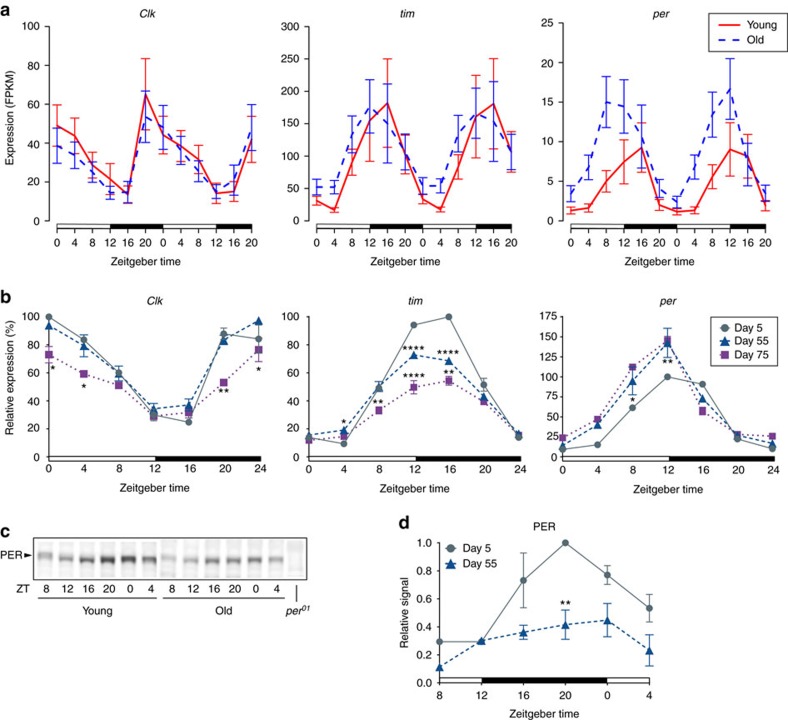
Core clock gene expression in young and old flies.(a) Age-dependent expression of three clock genes (RNA-seq). Each period of ZT 0–20 represents a distinct biological replicate. Error bars represent 95% confidence intervals reported by Cuffdiff. (b) qRT-PCR expression of per, tim and Clk in heads of females aged to 5, 55 and 75 days. Expression is reported as per cent of peak expression in day 5 flies. Data are mean (from two cycles)±s.e.m. (c) PER western blot from heads of young or old w flies collected at indicated ZT. The arrow indicates PER protein, with estimated molecular weight of 127-130 kDA, depending on the phosphorylation status. (d) PER levels (mean±s.e.m.) from western blot in c; n=3 biological replicates. (b,c) *P≤0.05; **P≤0.01; ***P≤0.001; ****P≤0.0001 (two-way ANOVA with Bonferroni correction; day 55 change is relative to day 5 values, and day 75 change is relative to day 55 values).